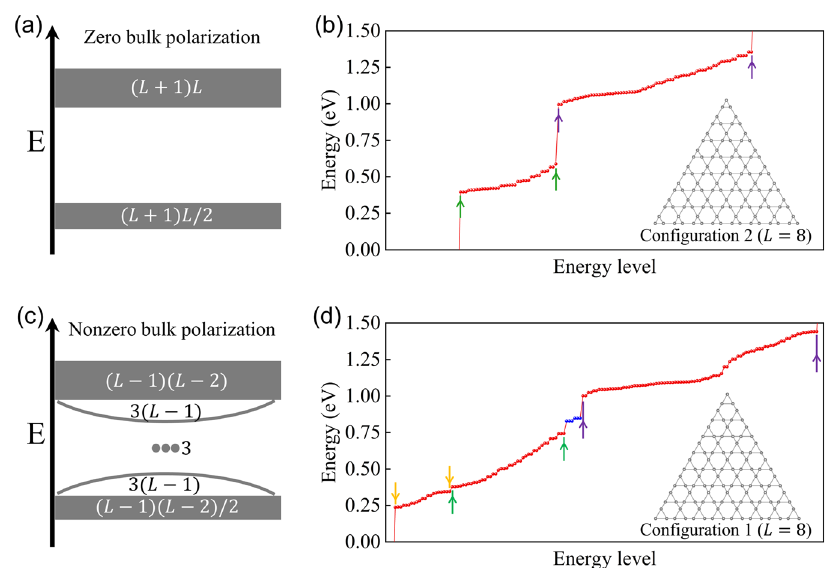
Fig. 5 Demonstrating the existence of the hidden corner states of ML Nb 3 TeCl 7 . a Schematic showing the state number of a L -size nanodisk with zero bulk polarization. b Counting the state number of the Nb 3 TeCl 7 nanodisk of Con fi guration 2 L ¼ 8 ð Þ . There are 36 states between green arrows and 72 states between purple arrows. c Schematic showing the state number of a L -size nanodisk with nonzero bulk polarization. d Counting the state number of theNb 3 TeCl 7 nanodisk of Con fi guration 1 L ¼ 8 ð Þ . There are 21 states between yellow arrows, 42 states between green arrows and 87 states between purple arrows.